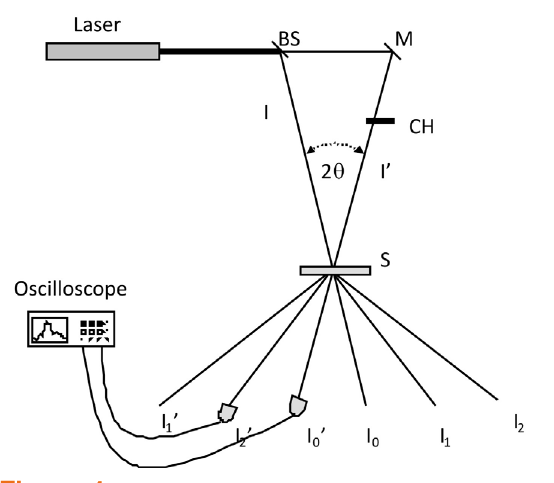
Figure 1. Schematic diagram of the configuration used for holographic grating inscription using degenerate two- wave mixing experiment. BS - beam splitter, M - mirror, CH - chopper, S -